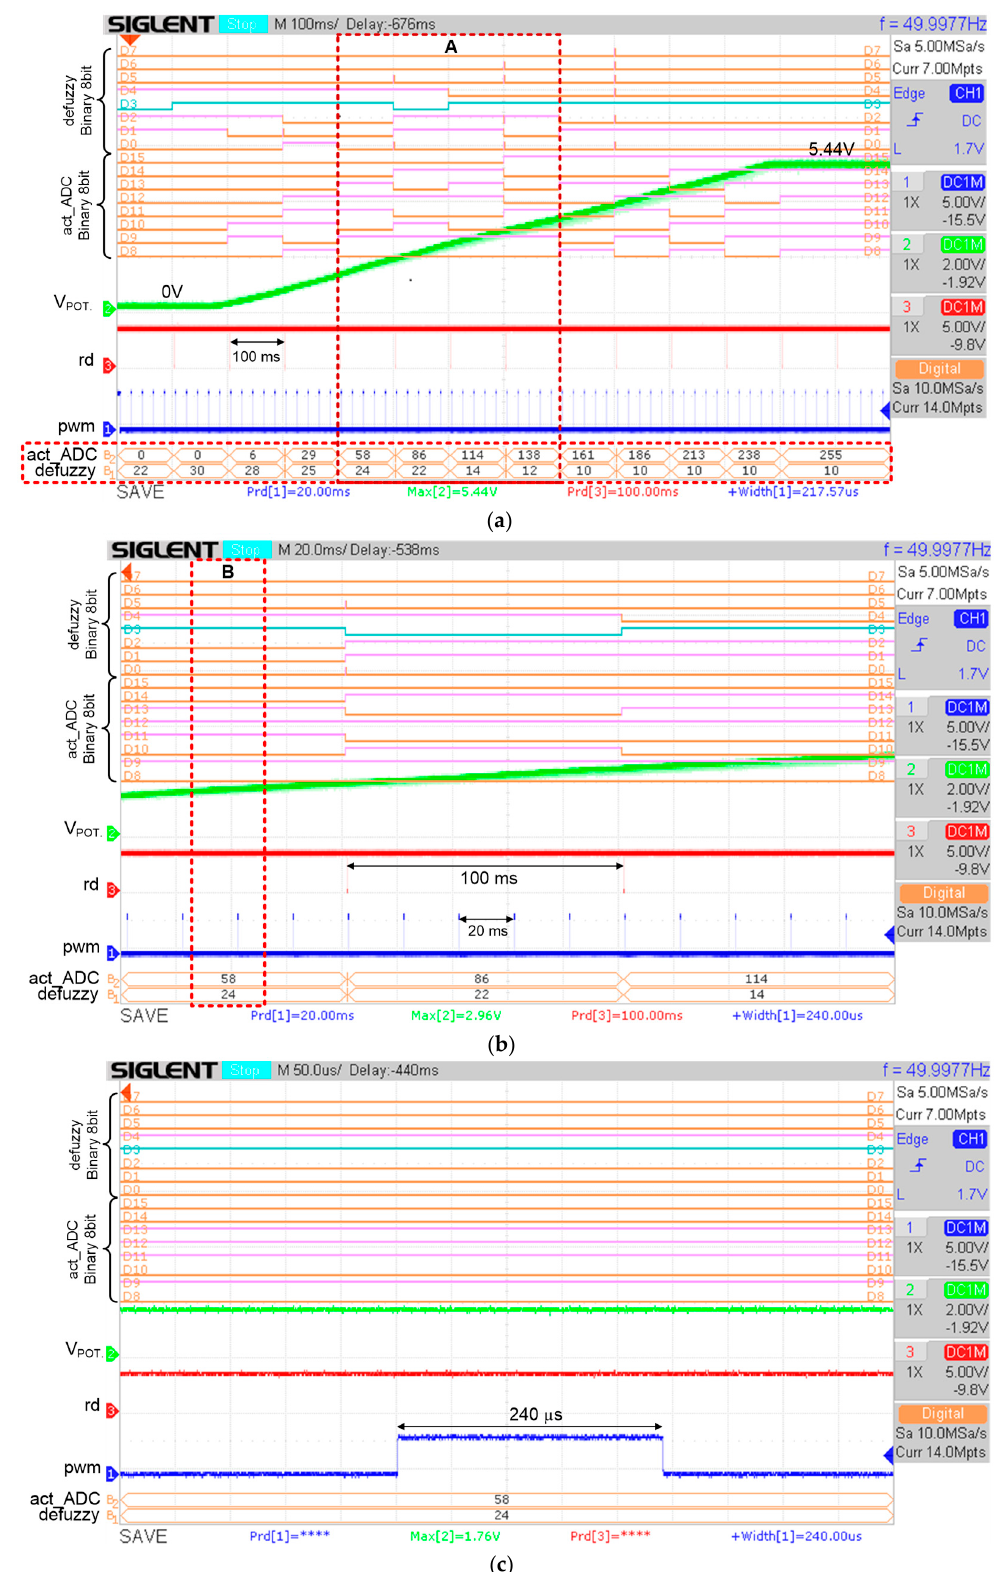
Figure 17. Hardware measurement of the digital FFC defuzzy output ("defuzzy") from the acquired ADC data ("act_ADC") every 100 ms. The actual knee angle movement is represented by the rotary 10k ohm potentiometer voltage (V POT ). ( a ) Defuzzy output values for reference angle = 40 ◦ ; ( b ) Zoom view into marked area A; ( c ) Zoom view into marked area B for a pulse width of 240 µ